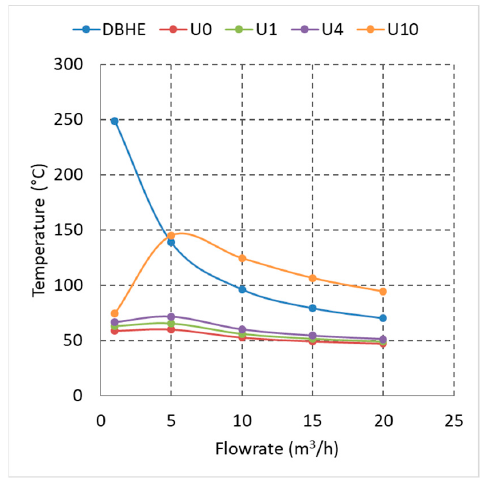
Figure 12. Outlet temperature vs flow rate (after six months of startup). Analysing the producible thermal power, the DBHE presents a higher value, approx- imately 0.5 MW, compared to the configurations U0, U1 and U4 of the ULHE (Figure 13). Only the extended design U10, attaining the same depth as the DBHE, gives higher ther- mal power of up to 1.2 MW with a temperature of 94.5 °C. The DBHE maximum thermal power is approximately 0.7 MW with an outlet temperature of 70 °C. Matching conditions between the two configurations are near a flow rate of 5 m 3 /h: the outlet temperature is 140 °C, the thermal power is close to 0.6 MW for both designs, and there is no additional pumping power.